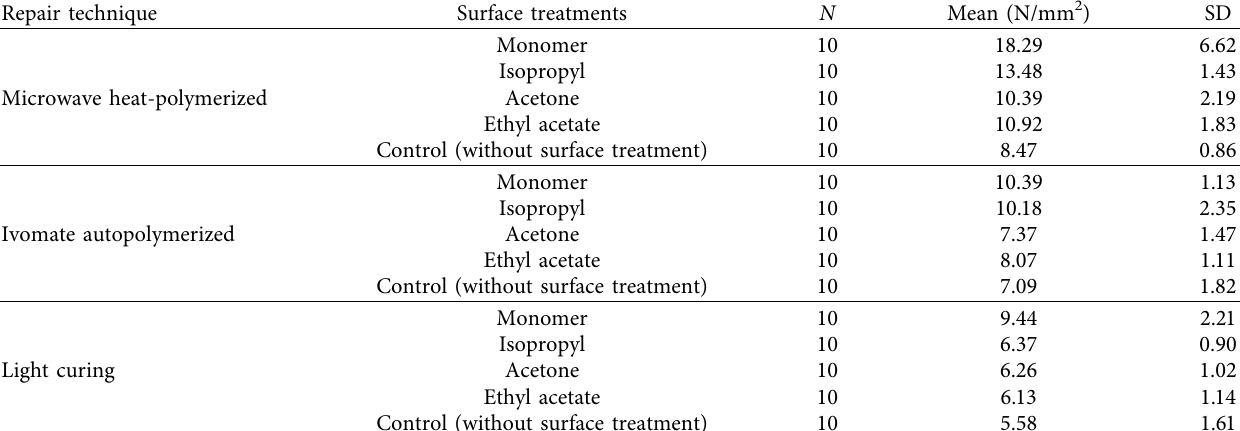
Table 2: Mean and standard deviation (SD) of transverse strength of nylon base repaired with different materials, curing techniques, and surface